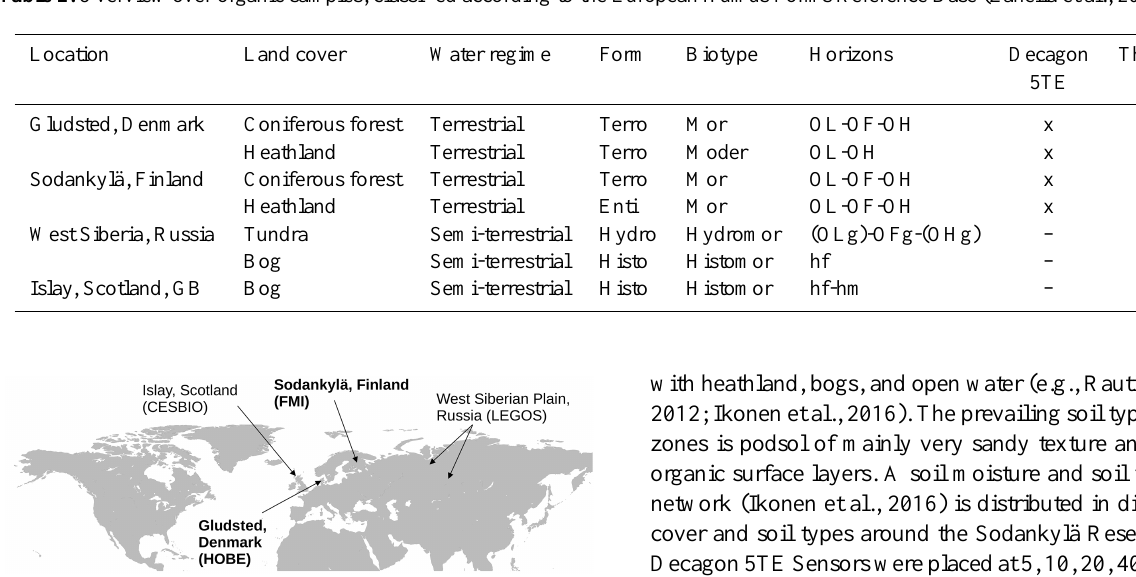
Table 2. Overview over organic samples, classified according to the European Humus Forms Reference Base (Zanella et al., 2011).